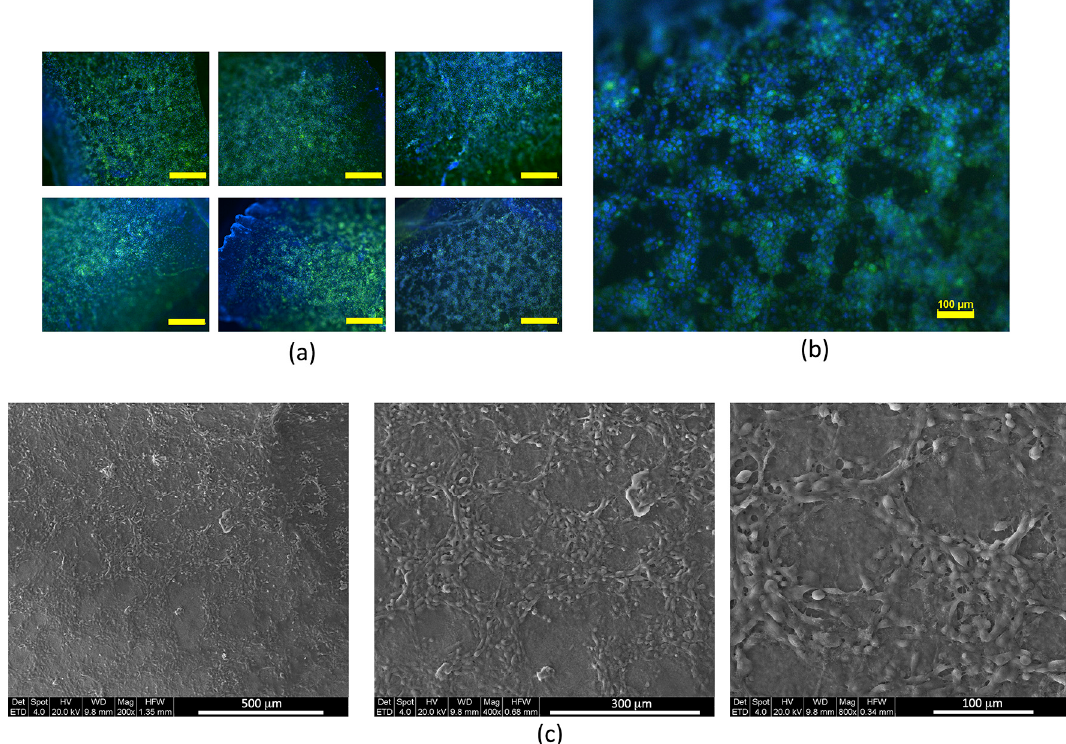
Figure 5. ( a ) MAEC GFP + were seeded on the ossicles and allowed to adhere for 24 h. Then, a treatment with VEGF (10 ng/mL) was performed for 2, 4, and 6 h. It is possible to observe a hint of organization in cords arranged in network after 6 h of stimulation by VEGF (scale bar 500 µ m); ( b ) enlargement